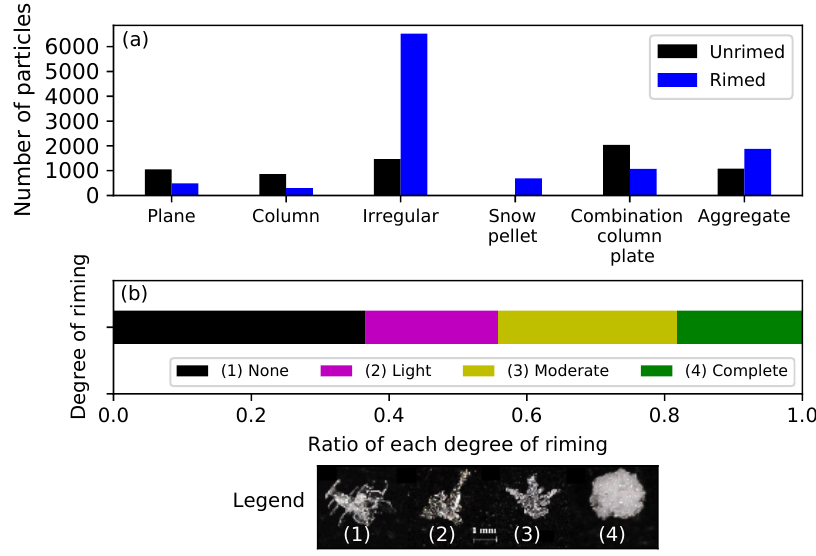
Figure 11. (a) The number of unrimed and rimed ice crystals and solid precipitation particles identified using the microphotography observa- tions over the March–April 2015 period. For simplification purposes, the other solid precipitation category was omitted from the image since fewer than five of these particles were observed. (b) The fraction of particles with varying degrees of riming as identified in microphotography observations over the March–April 2015 period. The insert provides a visual reference for the different categories of riming.